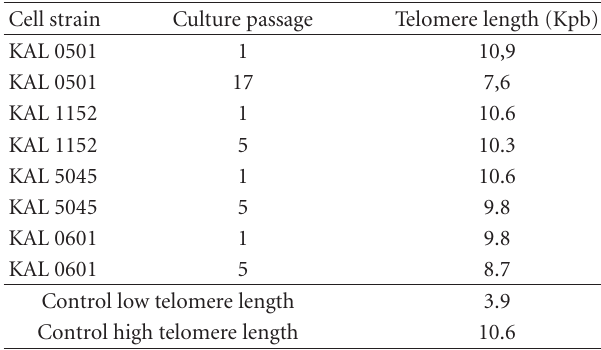
Figure 2: Pictures of KAL0501 in culture at di ff erent passages (x100). Primary keratinocytes KAL0501 are culture in green medium on human feeder layer. Their morphology has changed during the culture from passage P1 to P25. Table 1: Telomere length of